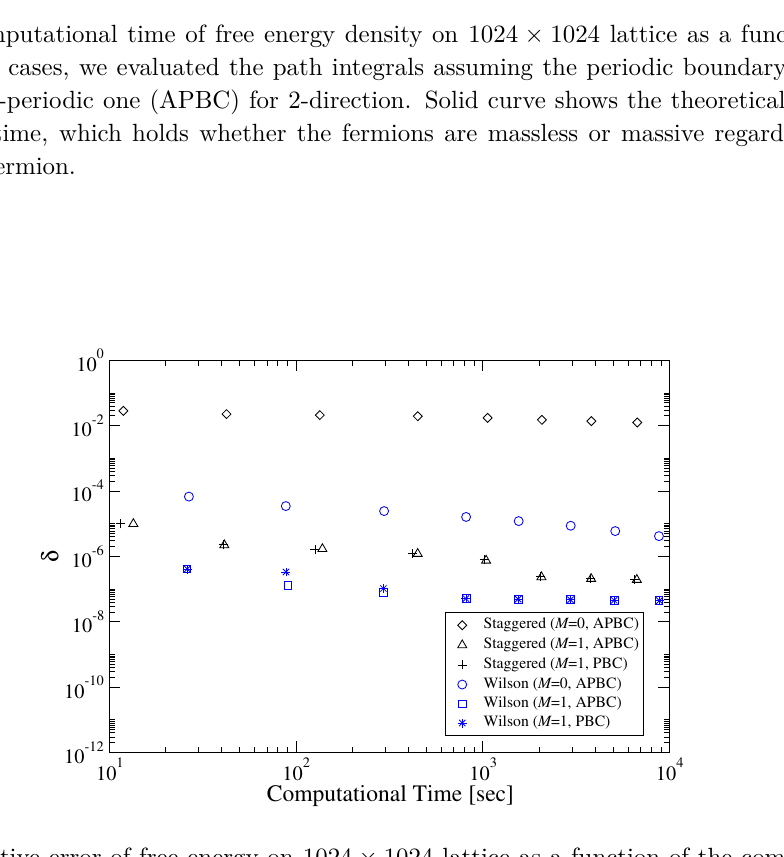
Figure 8 . Relative error of free energy on 1024 × 1024 lattice as a function of the computational time. Different symbol corresponds to the Wilson or staggered fermions with M = 0 , 1 . For the massive cases, we evaluated the path integrals assuming the periodic boundary condition (PBC) and anti-periodic one (APBC) for 2